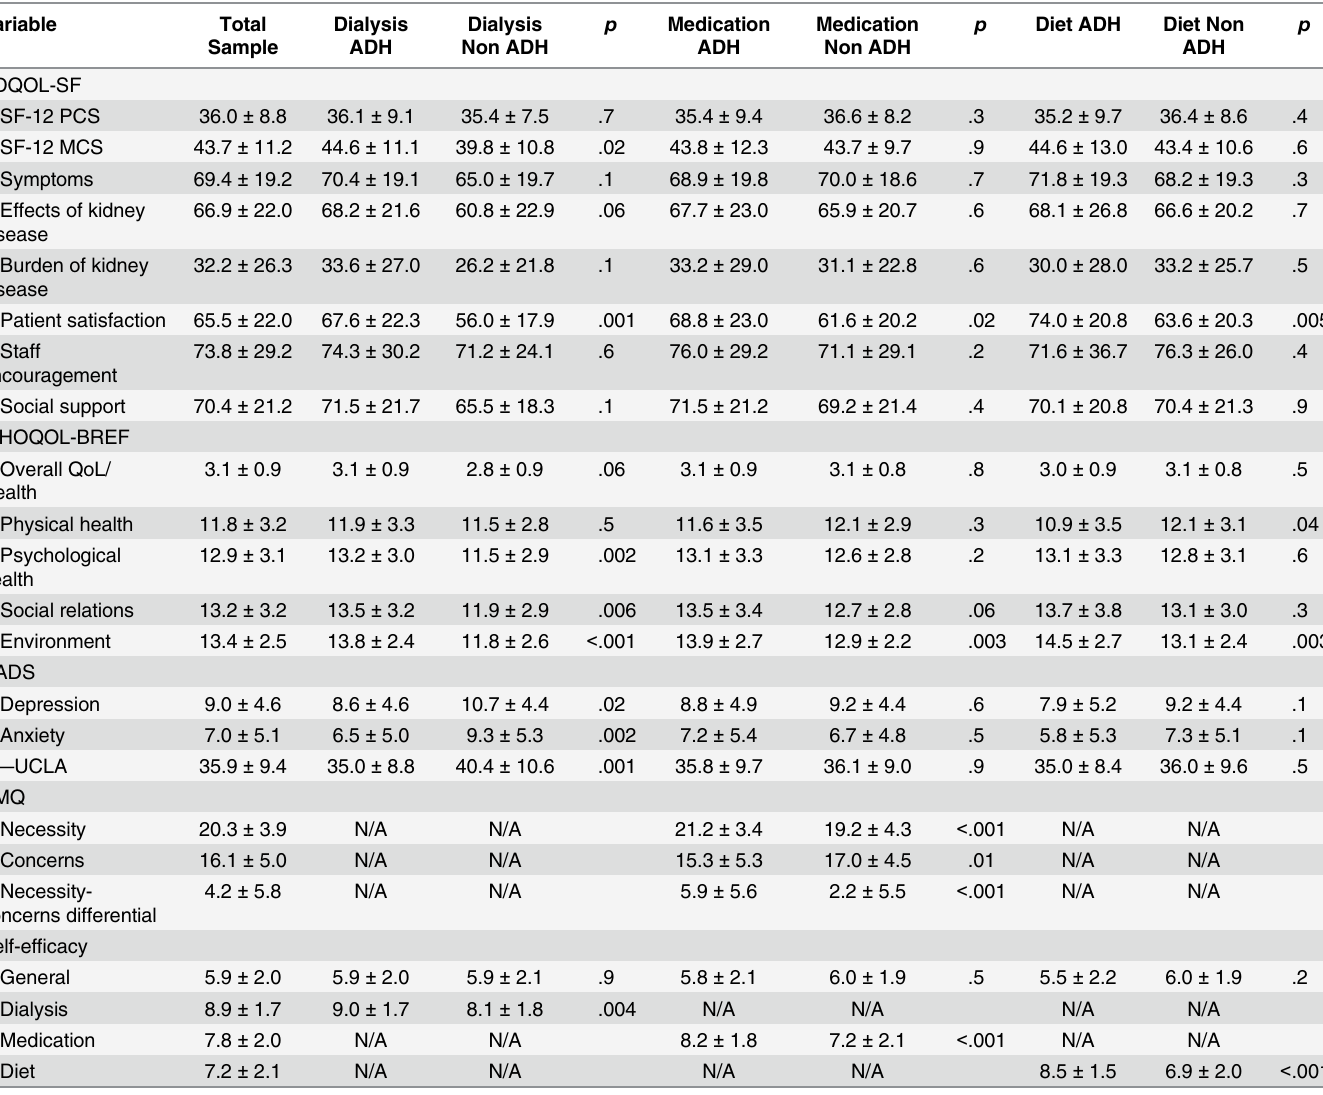
Table 3. Means and SDs for QOL and psychosocial parameters for total sample and as stratified by adherence status on diet, medication and